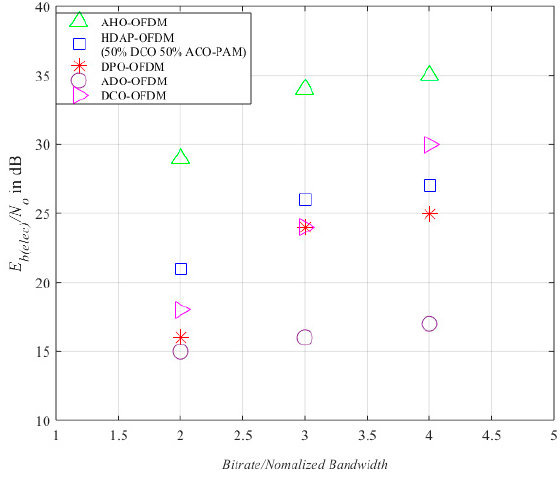
Figure 5. Electrical energy per bit to noise power spectral density ( E b ( elec ) / N O ) versus bit rate/normalized bandwidth ( R ) for hybrid orthogonal frequency division multiplexing (OFDM) considering a bit error rate (BER) of 10 − 3 .